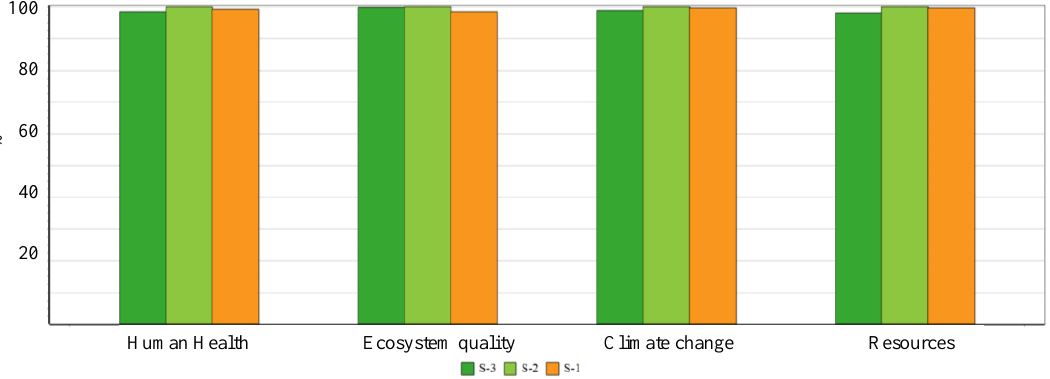
Figure 6. Midpoint life cycle impacts of studied municipal solid waste management (MSWM)systems